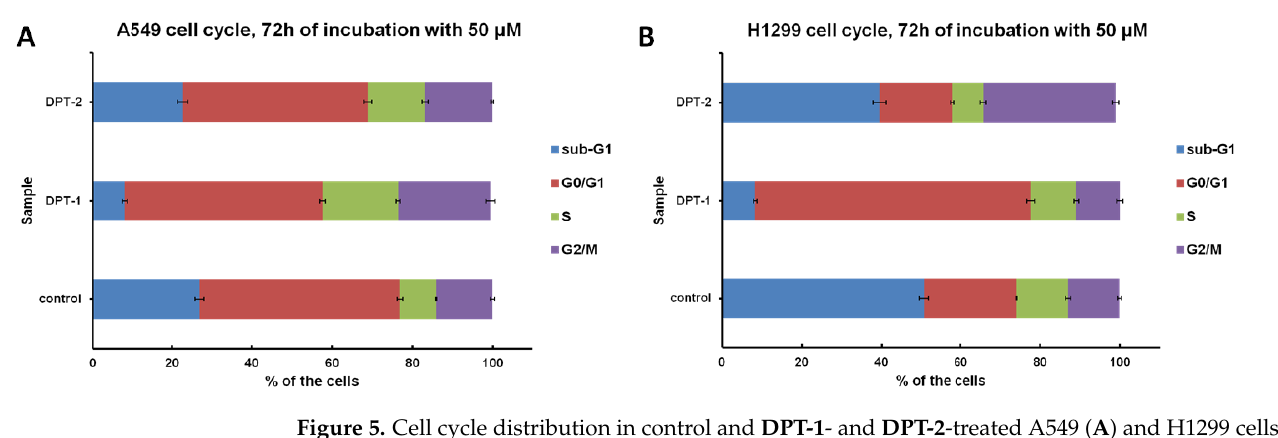
Figure 5. Cell cycle distribution in control and DPT-1 - and DPT-2 -treated A549 ( A ) and H1299 cells ( B ) treated for 72 h at a dose of 50 µM, followed by flow cytometry measurements.